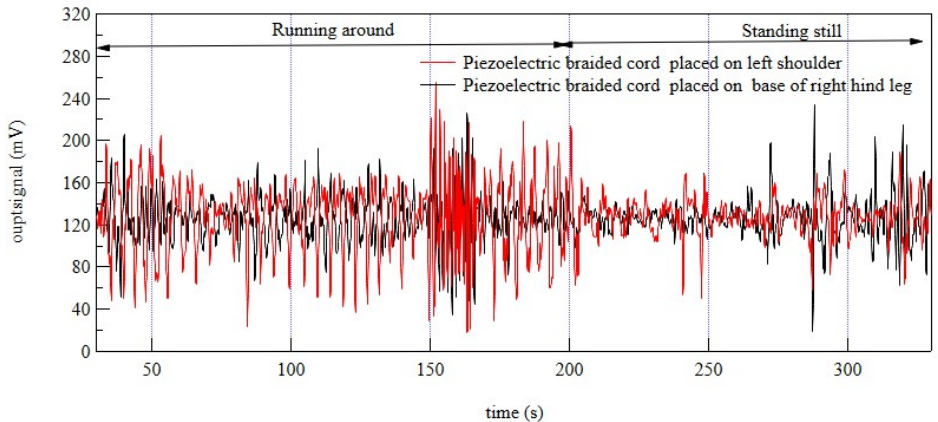
Figure 12. Response signals from piezoelectric PLLA braided cords embroidered on the shoulders and base of hind legs of the dog wear when the toy poodle is in motion and at rest.